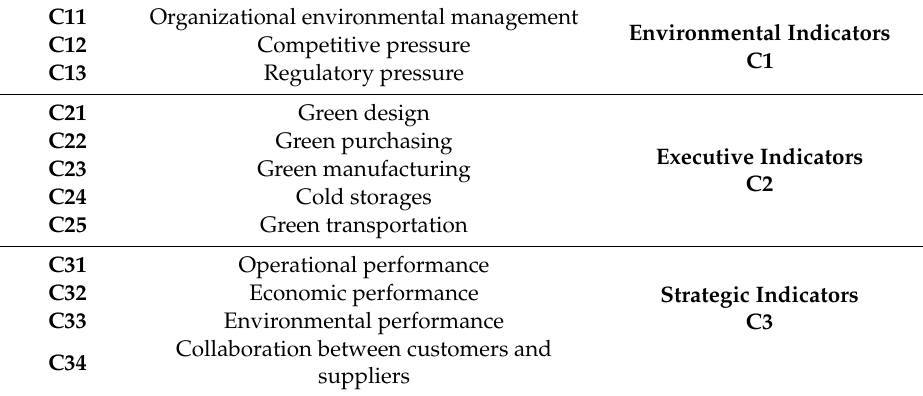
Table 1. Performance